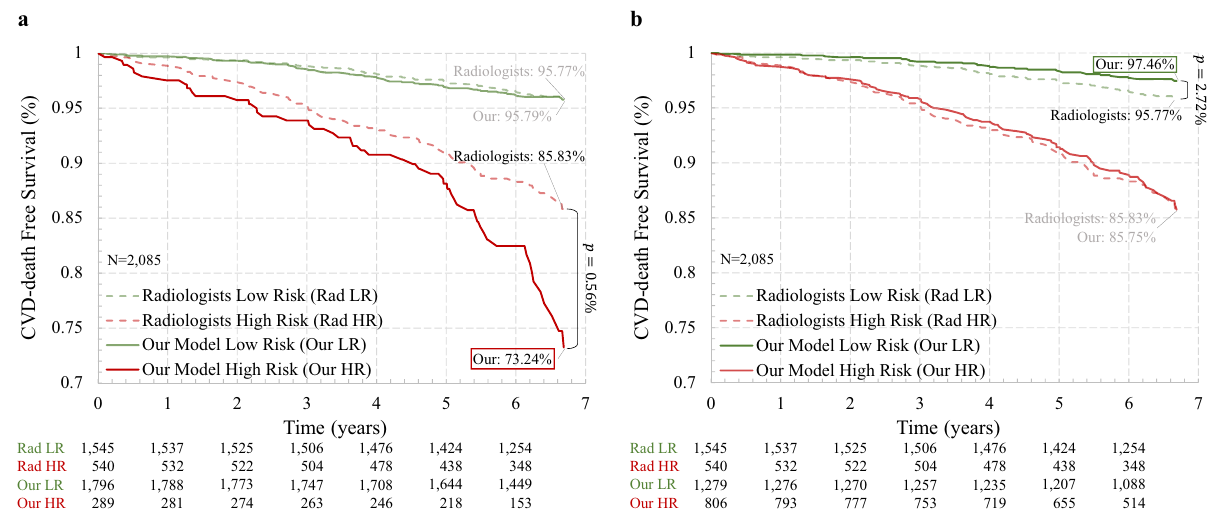
Fig. 3 Kaplan – Meier curves on the NLST dataset. Comparison of our model with the radiologists. Thresholds were selected on the CVD risk score calculated by our model to enforce the low ( a ) or high ( b ) risk group has a similar survival probability with that of the